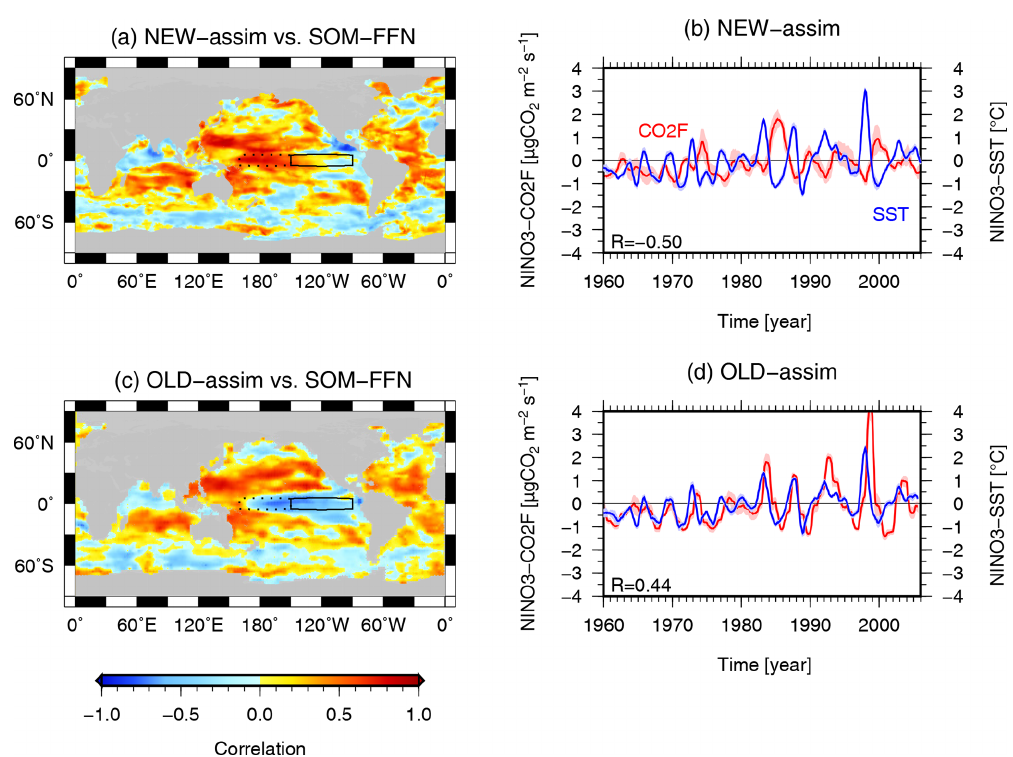
Figure 1. (a, c) Maps showing the correlation coefficient between monthly CO2F anomalies derived from SOM-FFN and that of (a) NEW- assim and (c) OLD-assim. The analysis period is from 1982 to 2005. The solid boxes show the Niño3 region (5 ◦ S–5 ◦ N, 90 ◦ –150 ◦ W) and the dotted boxes show the Niño4 region (5 ◦ S–5 ◦ N, 160 ◦ E–150 ◦ W). (b, d) Time series of the detrended NINO3-SST (blue line) and NINO3-CO2F (red line, positive upward) anomalies simulated with (b) NEW-assim and (d) OLD-assim. Values plotted are the 1-year running mean, and the shading in panels (b) and (d) shows the ensemble spread (1 σ ). R denotes the correlation coefficients between the detrended ensemble mean NINO3-SST and NINO3-CO2F anomalies, with a 1-year running mean filter